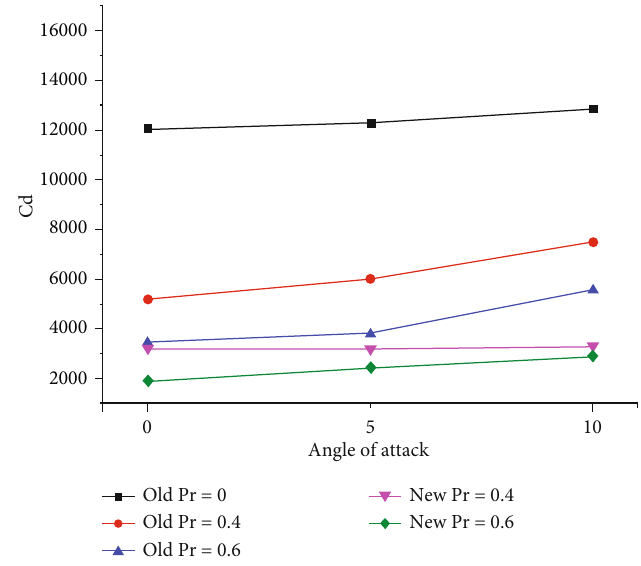
Figure 18: Resistance coe ffi cient at di ff erent pressure ratios and angles of attack.